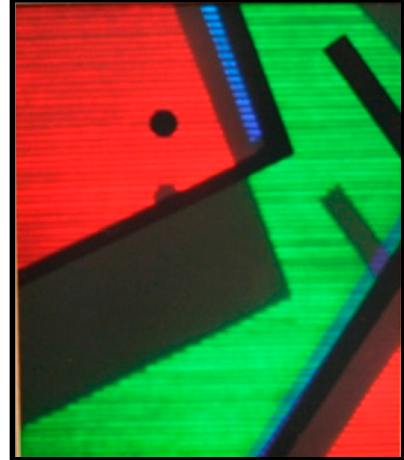
Figure 1. A 9 ″ × 7 ″ pseudo-colour hologram titled Color Study with Light Blocks created by the author in 1985. It shows the reconstruction with an MR-16 warm temperature (~2900 K) lamp.